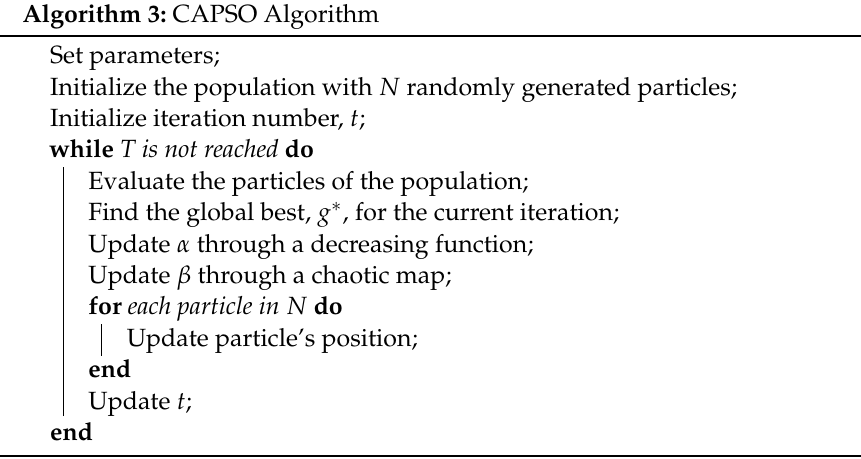
Algorithm 3 contains simple pseudocode for CAPSO. Algorithm 3: CAPSO